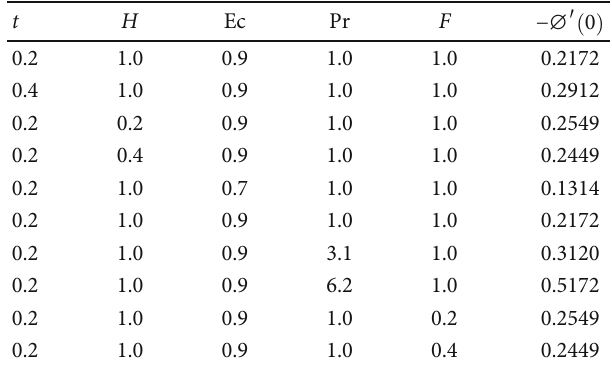
Figure 14: Increasing values of Ec for velocity fi eld when Gr = 5 , t = 2 , Kc = 1 : 5 , k = 1 , Gc = 5 , M = 5 , Pr = 6 : 2 , m = 1 , Sc = 2 : 01 , ⋋ = 1 , H = 2 , and F = 1 . Table 1: Distinct values of t , F , Ec, H , and Pr for the Nusselt number ( −∅ ′ ð 0 Þ ) at the wall.